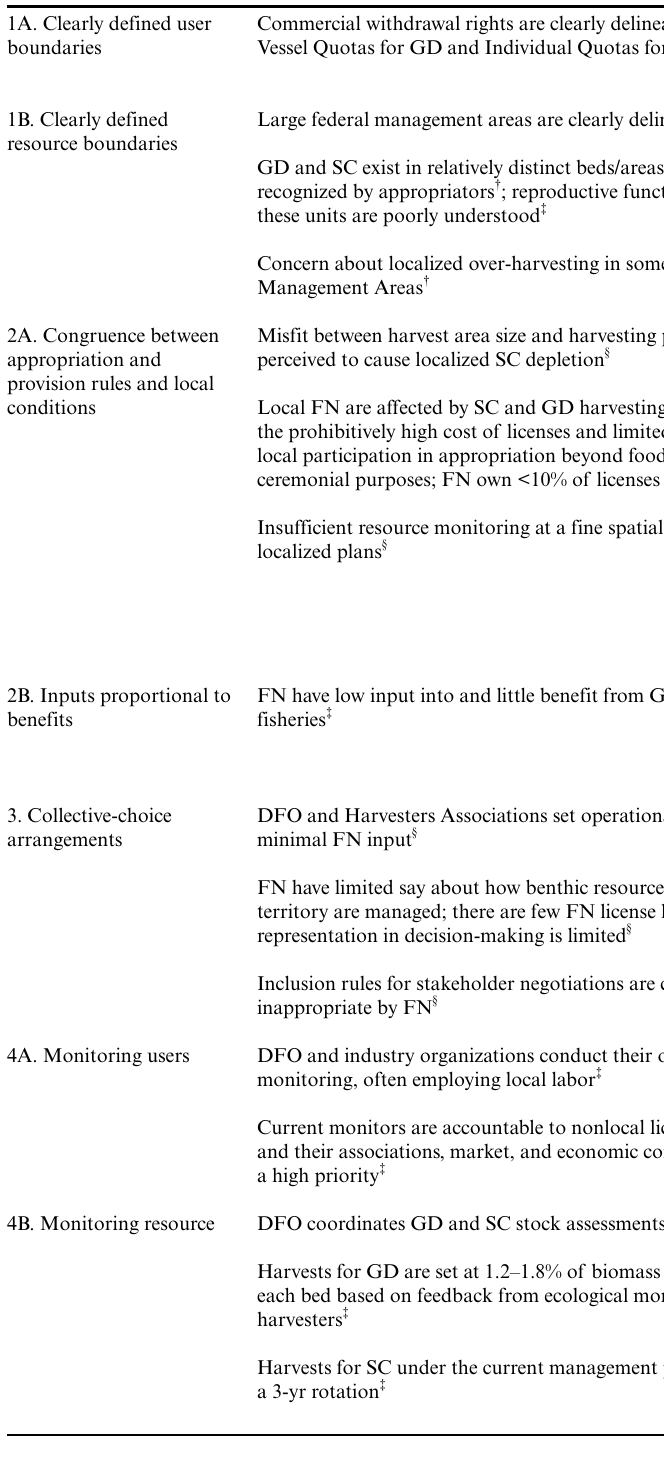
Table 2. Common-pool resource design principles in relation to central coast First Nations sea cucumber and geoduck management context and future goals. GD = geoduck, SC = sea cucumber, FN = First Nation. Design